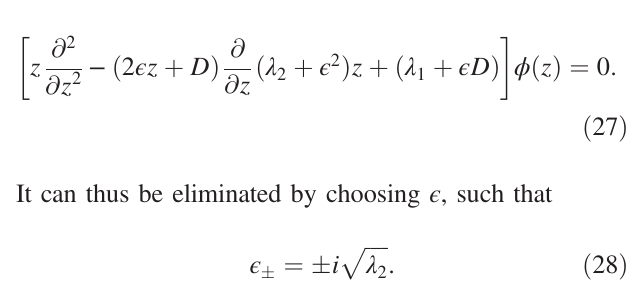
ffiffiffiffiffiffiffiffiffiffiffiffiffi − λ